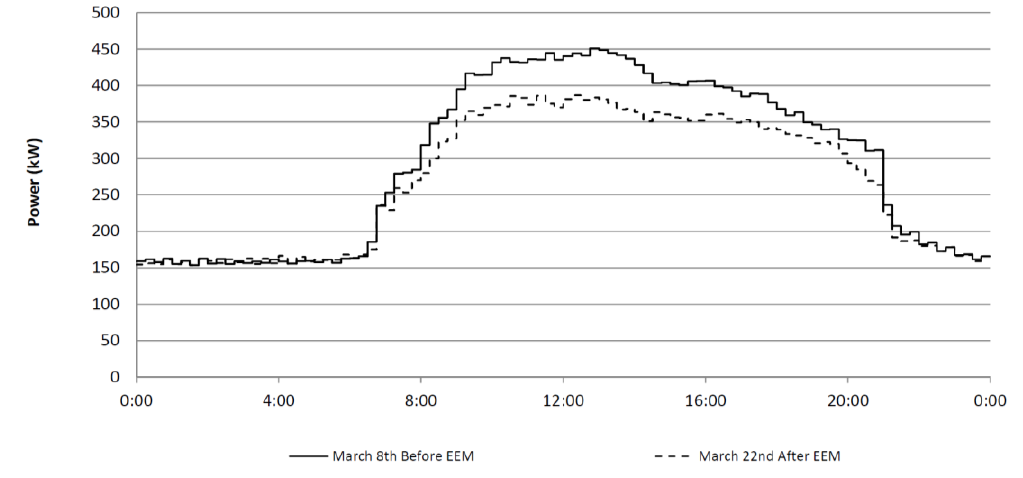
Figure 4. Building 8G consumption before and after the EEM (working days).